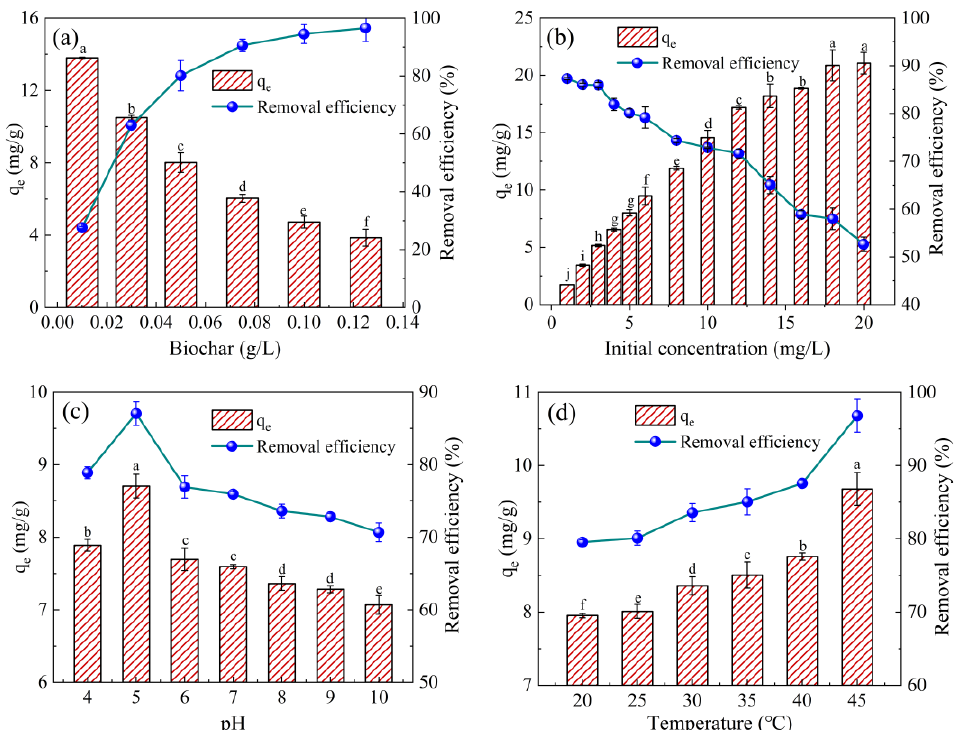
Figure 2. Effect of experimental conditions on adsorption of TE by WHCBC: ( a ) effect of WHCBC dosage on TE removal; ( b ) effect of initial TE concentration on TE removal; ( c ) effect of solution pH on TE removal; ( d ) effect of solution temperature on TE removal ( C 0 = 5 mg/L, m = 0.05 g, t = 0–240 min, T = 25 ◦ C). Different letters indicate significant differences between different adsorption conditions at the 0.05 level, tested via one-way ANOVA.